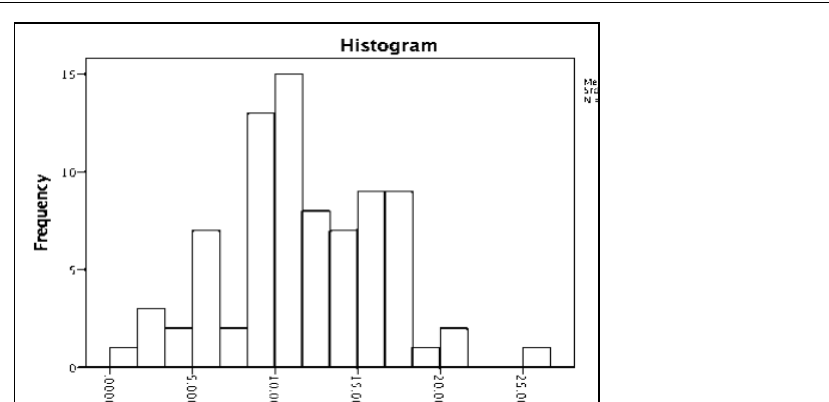
Figure 2: Histogram